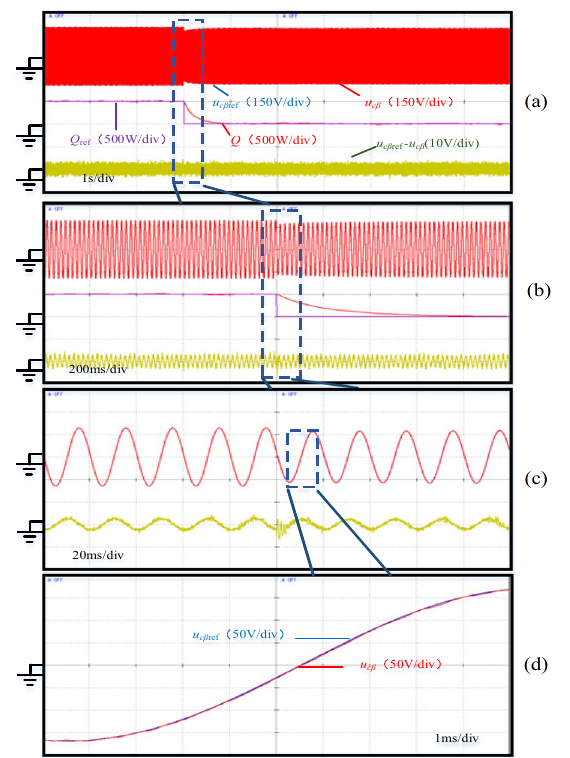
Fig. 17 Experimental waveforms during sudden change of reactive power with error compensation. a 1 s/div. b 200 ms/div. c 20